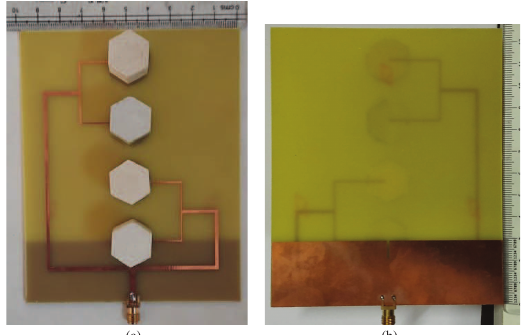
FIGURE 7: Proposed 4-element linear hexagonal DRA array: (a) Top-view (b)